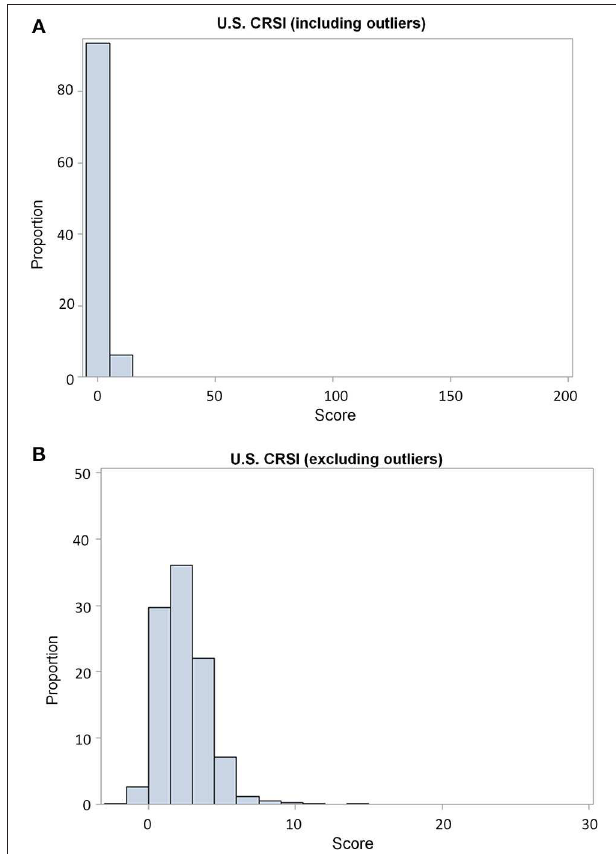
FIGURE 6 | ( A) The histogram shows severely right-skewed results in the distribution of calculated CRSI scores. A review of the results found that pattern was due to CRSI values for 12 of 22 boroughs in Alaska were far outside the 3rd quartile range rather than any specific data processing error. (B) After qualifying these 12 CRSI results as outliers, the histogram reflects a distribution pattern that was expected with the 12 outlier values were removed. Publications using the final CRSI measures report results, both with and without these qualified